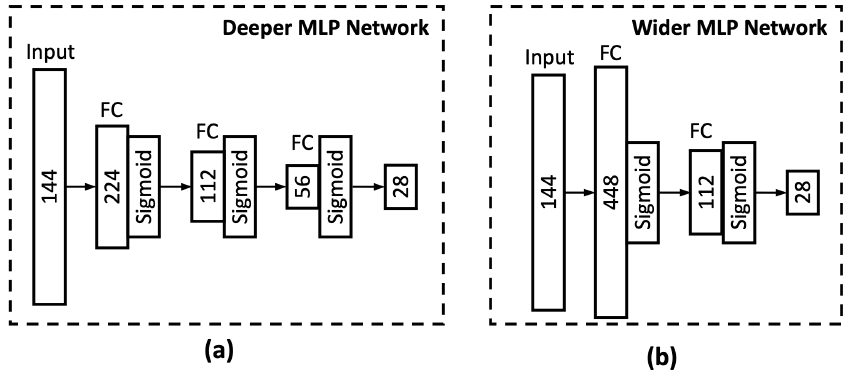
Figure A4. Proposed MLP ANN with increased ( a ) depth; ( b )